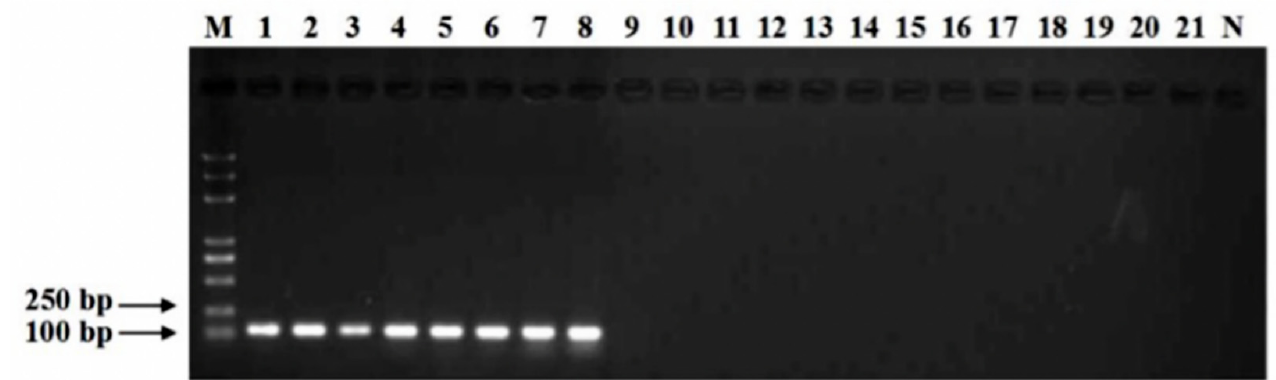
Figure 1. Specific detection of the cp gene in Cucumber green mottle mosaic virus (CGMMV) by the primer pair cp3-1F/cp3-1R. Lane M, BM 5000 bp DNA marker; Lanes 1 to 8, CGMMV (TG20091901, TG20091902, TG20081101, TG20081102, TG21061411, TG21061412, TG21121234 and TG21121235); Lane 9, Watermelon mosaic virus (HG16092601); Lane 10, Cucumber mosaic virus (TG18041704); Lane 11, Melon mosaic virus (TG19011201); Lane 12, Tobacco ring spot virus (HG18092107); Lane 13, Cucurbit chlorotic yellows virus (HG18111501); Lane 14, Zucchini yellow mosaic virus (NG17071124); Lane 15, Squash mosaic virus (SQ20041046); Lane 16, Melon yellow spot virus (MY20075501); Lane 17, Melon necrotic spot virus (MN21060102); Lane 18, Prunus necrotic ringspot virus (PNR20070108); Lane 19, Papaya ringspot virus (PR20040101); Lane 20, Tobacco mosaic virus (FQ18062901); Lane 21, Potato Y virus (MLS18080202); N, negative control.